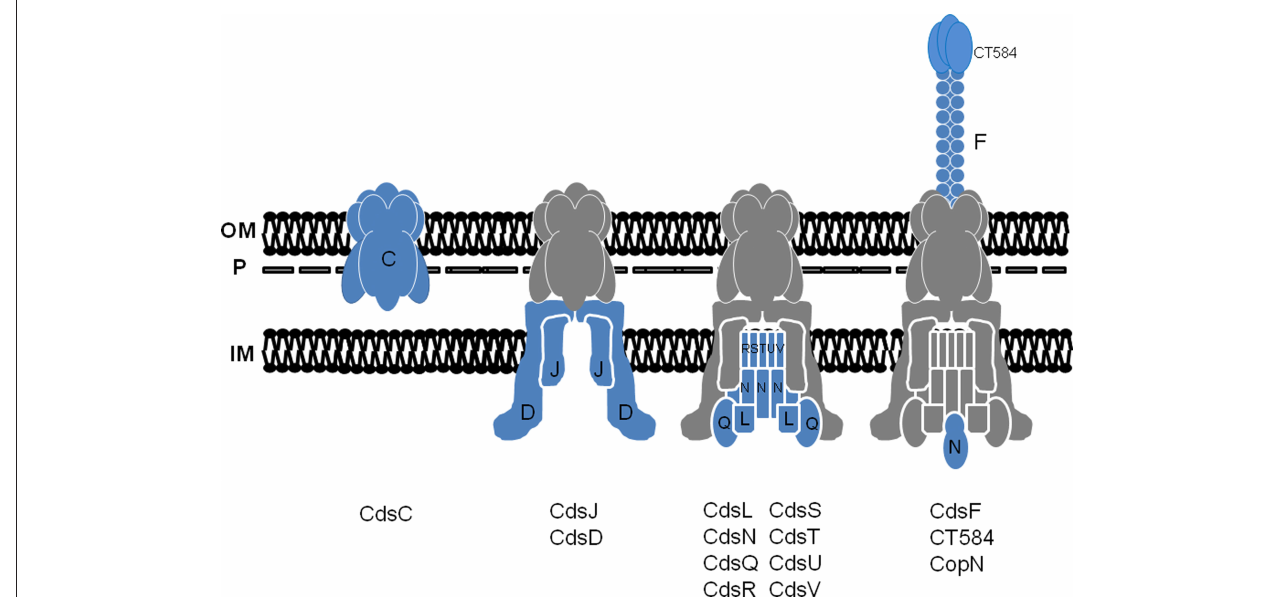
Figure 2 | a working model for the temporal assembly and composition of the chlamydial T3S apparatus. Stepwise addition of proteins is indicated with newly added components shown in blue and previously assembled components in gray (shown with Cds letter designation only). The basal apparatus spans the chlamydial inner membrane (IM), OmcB-containing P-layer (P), and outer membrane (OM). Flagellar homologs are omitted for